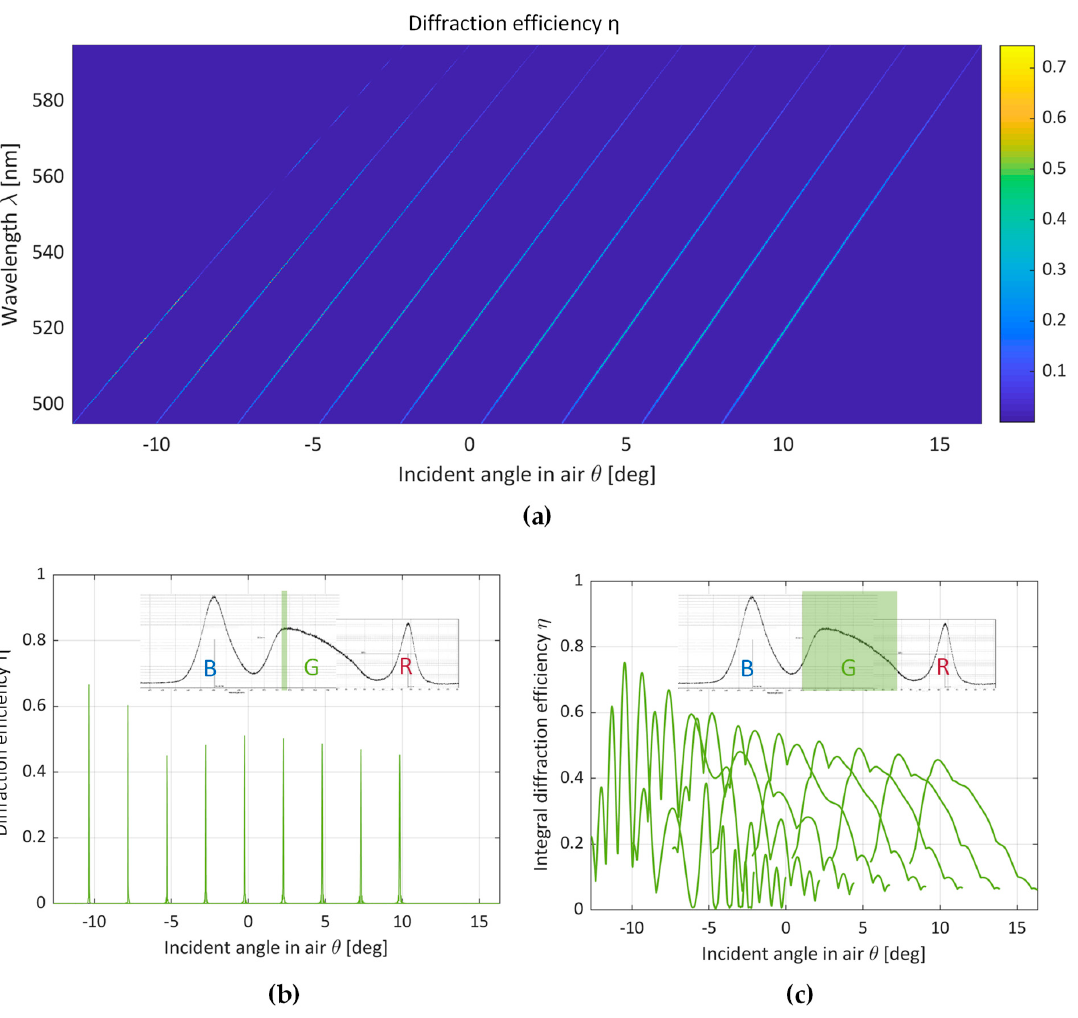
Figure 3. MVHGs diffraction efficiency analysis: ( a ) Spectral-angular diagram of diffraction efficiency; ( b ) Diffraction efficiency selectivity contours for spectral maximum; ( c ) Diffraction efficiency selectivity contours for a wide spectrum